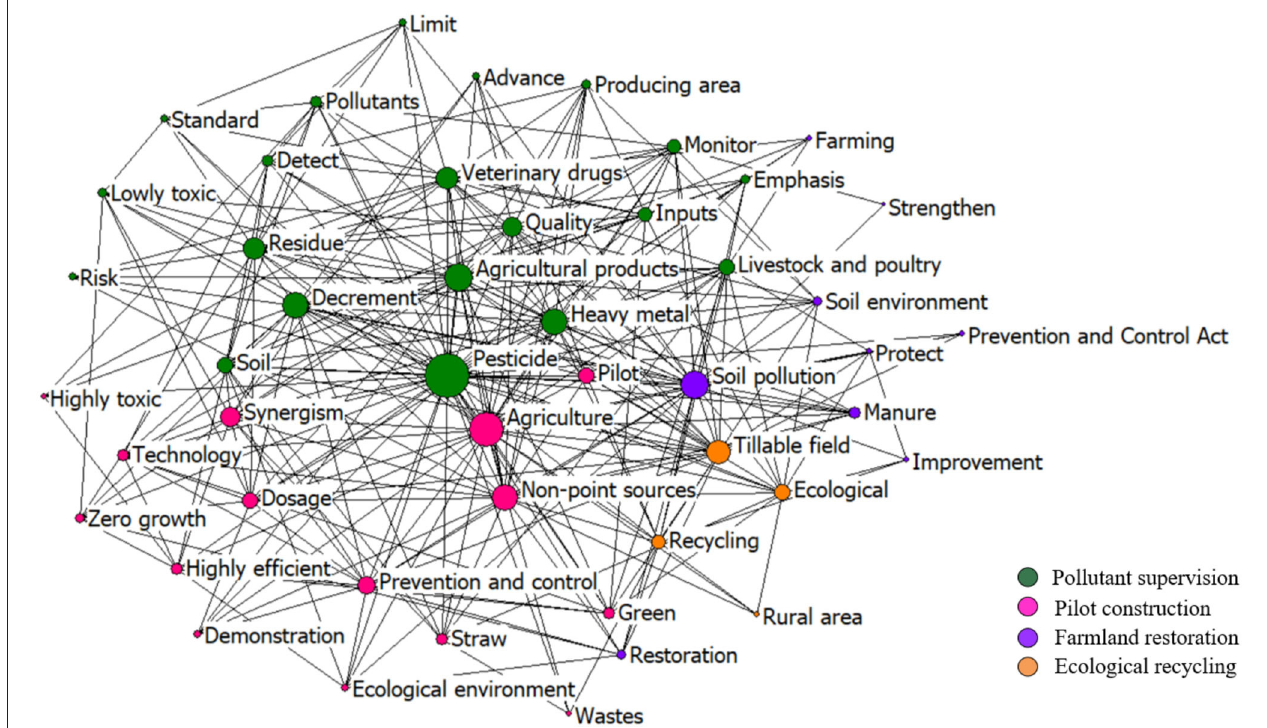
FIGURE 14 | The co-word network of the keywords in the policies during